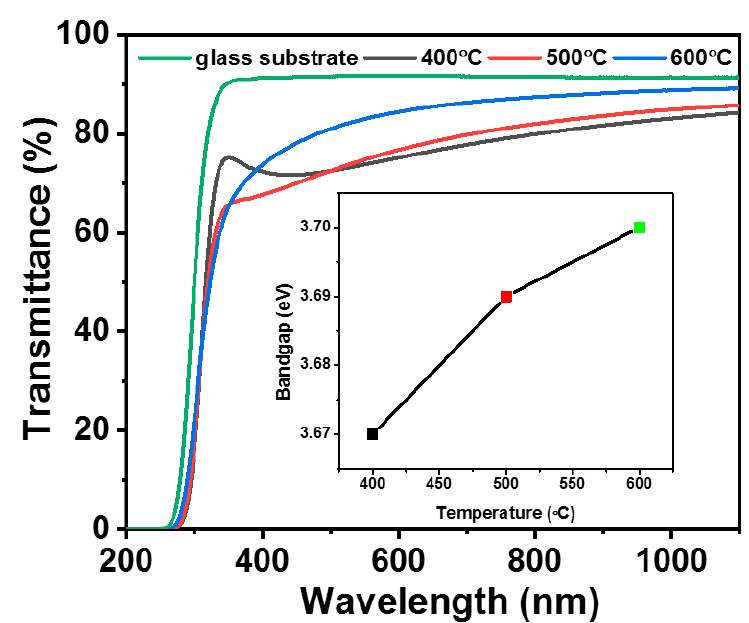
Figure 6. Transmittance spectra of post-annealed TiO 2 thin-films. (inset: Shift in band gap with annealing temperature).